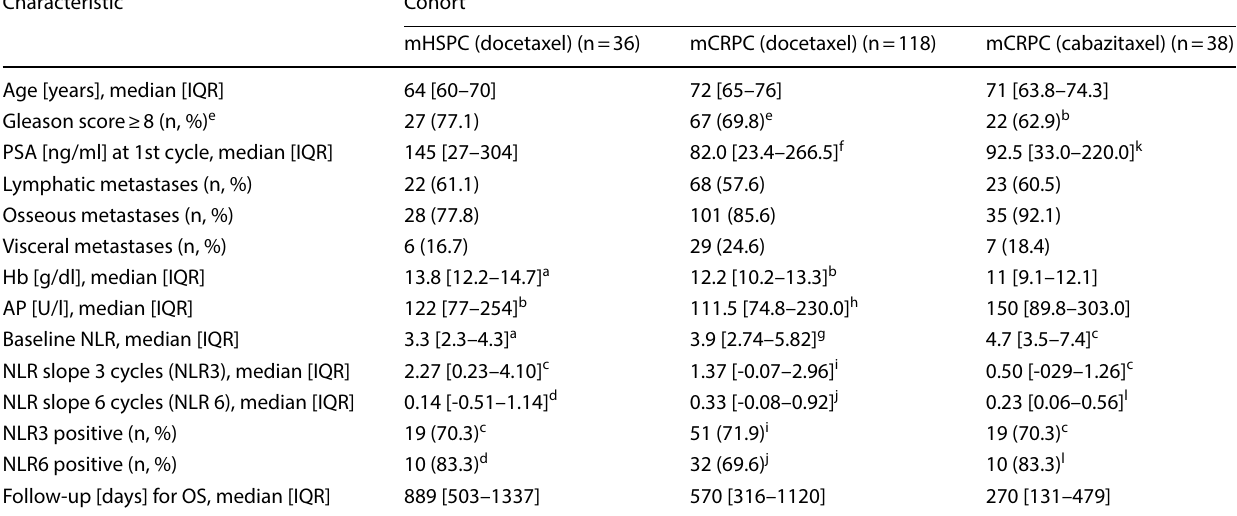
Table 1 Baseline characteristics of study